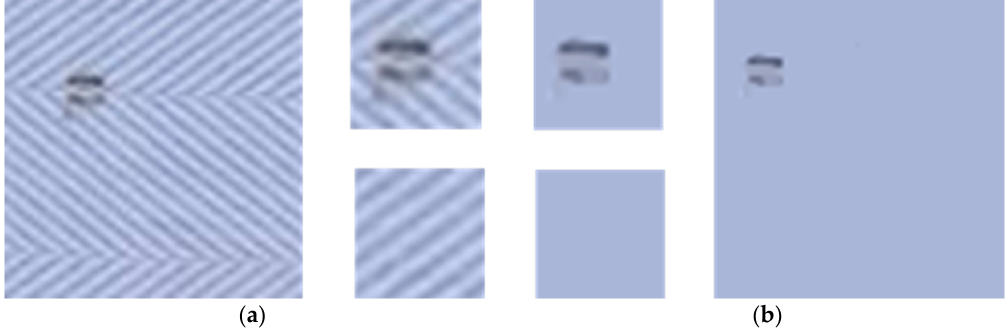
Figure 4. Smoothed fabric defect image using L0 gradient minimization (LGM). ( a ) Fabric defect image; ( b ) Smoothed fabric defect image.